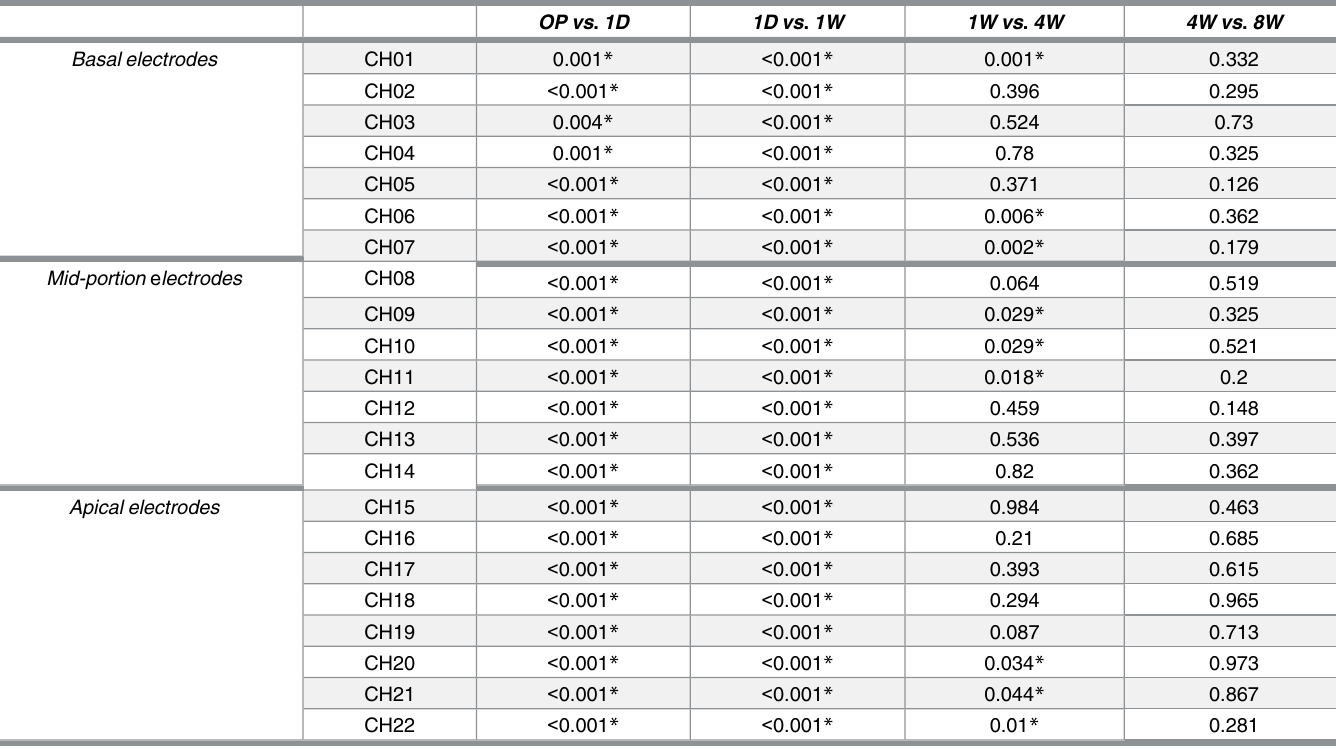
Table 2. Comparison of Impedances between Different Measurement Times.